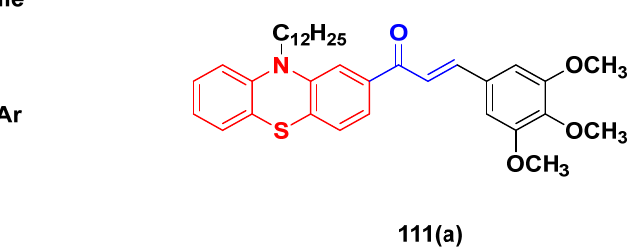
Figure 106. Structure of chalcone ‐ based phenothiazine hybrids and the most promising compound 111a. Table 93. In vitro cytotoxic activities of chalcone ‐ based phenothiazine hybrid compounds [ 111 ( a – d ), 111 ( a )].